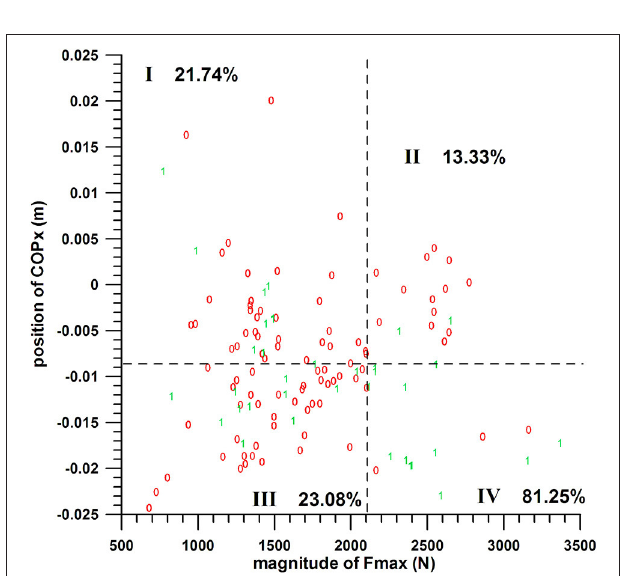
FIGURE 10 | Three-parameter analysis: positions of COPy against COPx; 1 = hit, 0 = miss; the dashed lines separate the favorable from the unfavorable ranges of COPx and COPy; I, II, III, IV = group codes from Table 2 , i.e., combinations of COPx and COPy; suffixes a and b denote Fmax in the unfavorable (Fmax < 2 kN) and favorable ranges (Fmax > 2 kN), respectively; Ia = parameter combination with COPx, COPy, and Fmax in their unfavorable ranges; IVb = all three parameters in their favorable